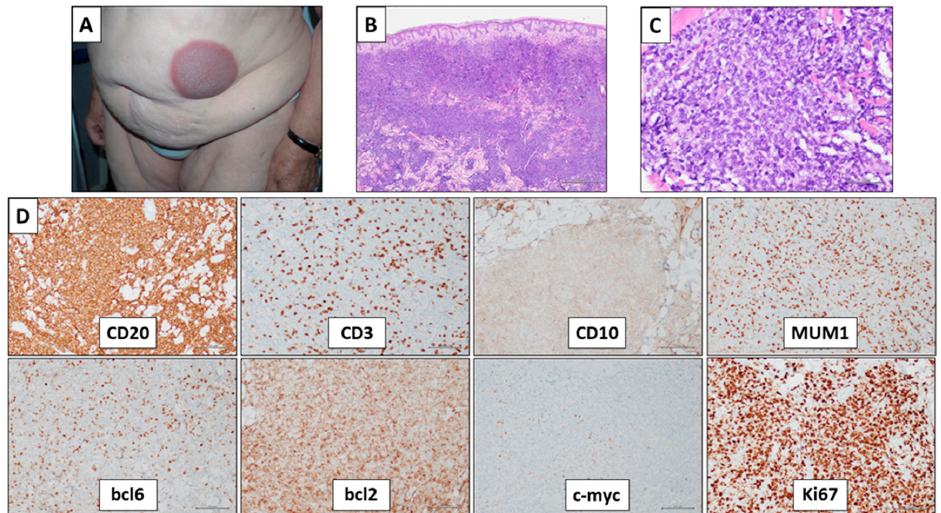
Figure 2. A case of primary cutaneous diffuse large B-cell lymphoma, leg type (PCDLBCL-LT). ( A ) A 76-year-old woman presenting a left-sided flank nodular lesion. The patients also showed a similar nodular lesion on the right scapular site and a poorly defined plaque lesion on the left leg. ( B ) Microscopic examination showing a diffuse lymphoid population filling the intermediate and deep dermis and sparing the papillary dermis (hematoxylin and eosin stain, original magnification 40 × ). ( C ) The neoplastic population includes large cells, with the morphological details of centroblasts and immunoblasts. Occasional small lymphocytes are present in the background (hematoxylin and eosin stain, original magnification 400 × ). ( D ) Immunohistochemistry showed positivity for CD20, MUM1, bcl6, and bcl2; slight positivity for CD10; negativity for CD3 (confirming the small number of reactive small T-cells) and c-myc. Proliferation index (Ki67) was about 80% (immunohistochemical stains, original magnification 200 ×